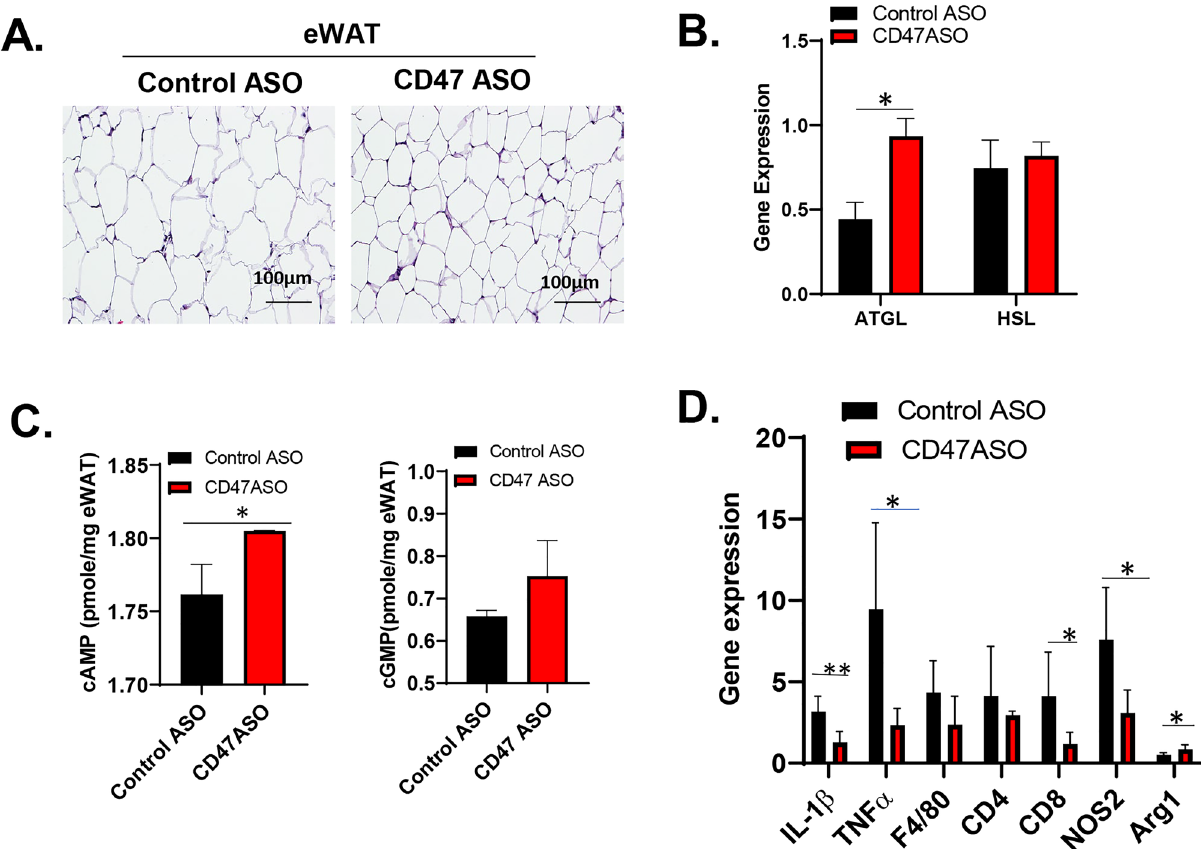
Figure 4. CD47ASO treatment reduced white adipose tissue inflammation in diet-induced obese mice ( A ). Representative H&E staining of eWAT (epidydimal white adipose tissue) from control ASO and CD47ASO treated mice. ( B ) Expression of lipolysis related genes (ATGL and HSL) by qPCR and normalized to β-actin levels; ( C ) cAMP and cGMP levels; ( D ) Expression of inflammation related genes by qPCR and normalized to β-actin levels. Data are represented as mean ± SE (n = 4–7 mice/group). * P < 0.05, ** P <